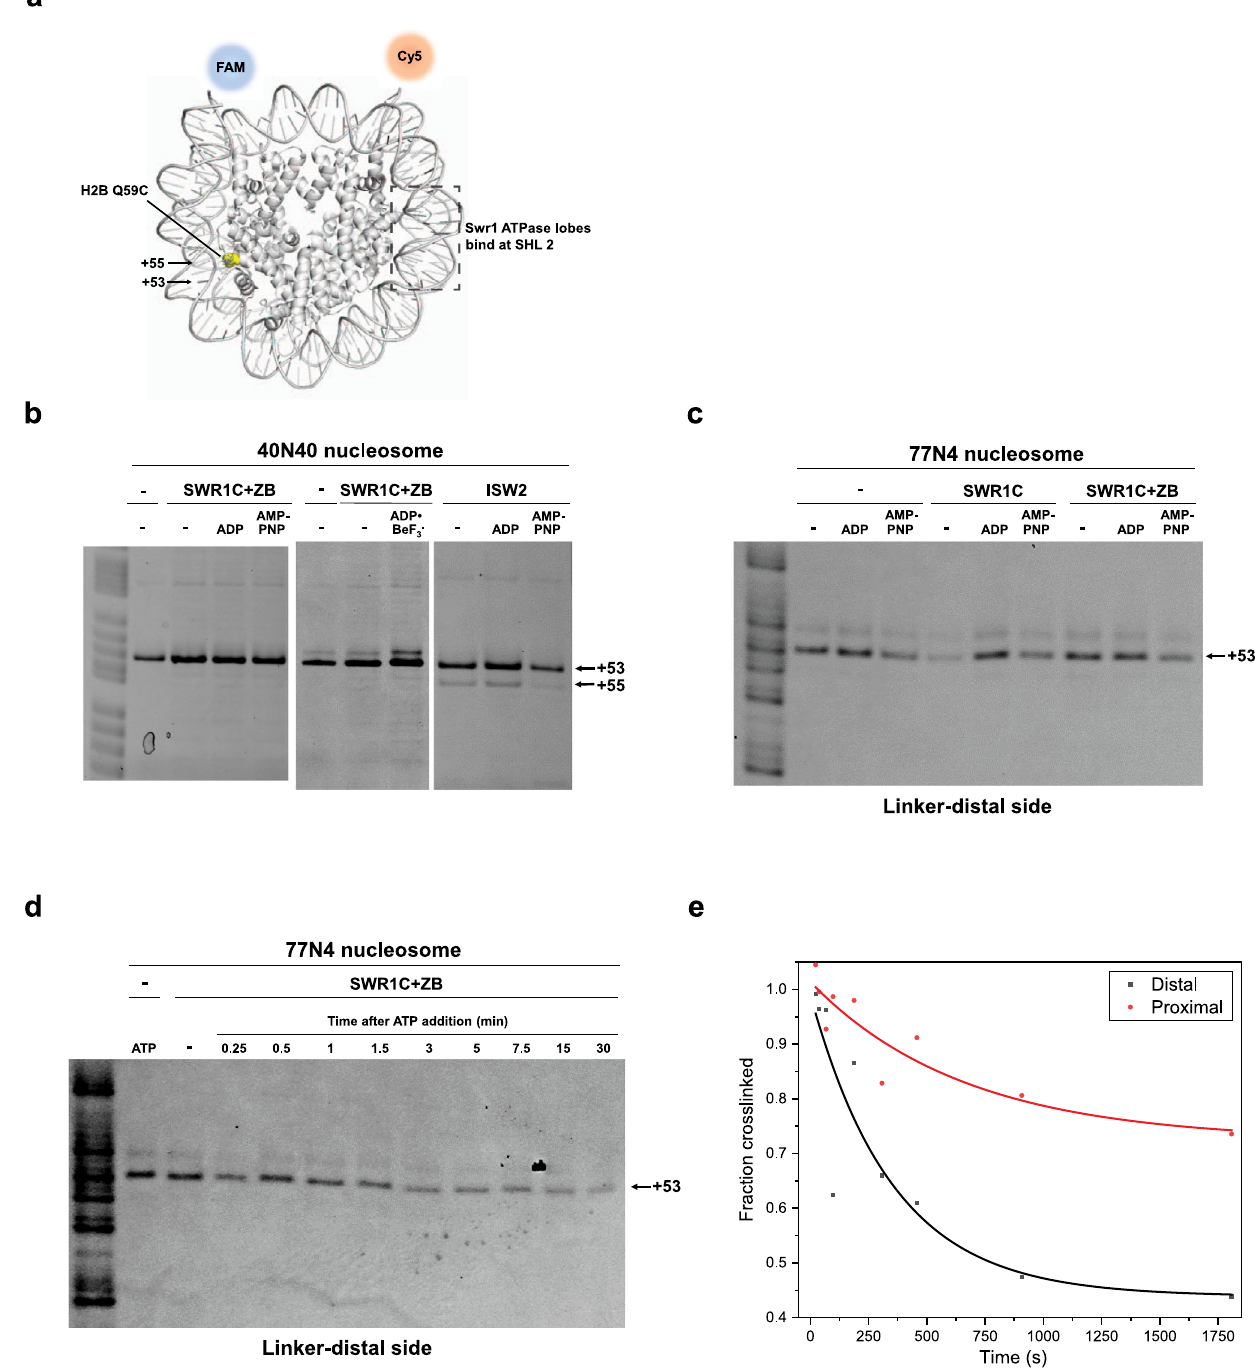
Fig.6|Site-directedDNA-histonemappingshowsthatSWR1Cdoesnotchange the path of nucleosomal DNA in any nucleotide state as a part of its ATP- dependent dimer exchange activity. a DNA-histone mapping schematics on a yeastnucleosome(PDB:1ID3).APB-labeledH2B-Q59CgeneratesaDNAcrosslinkat SHL5.5 (+53). b ISW2 binding in apo or ADP-bound state induces a 2-nucleotide translocation atSHL5.5 toward the dyadon a center-positioned nucleosome,while